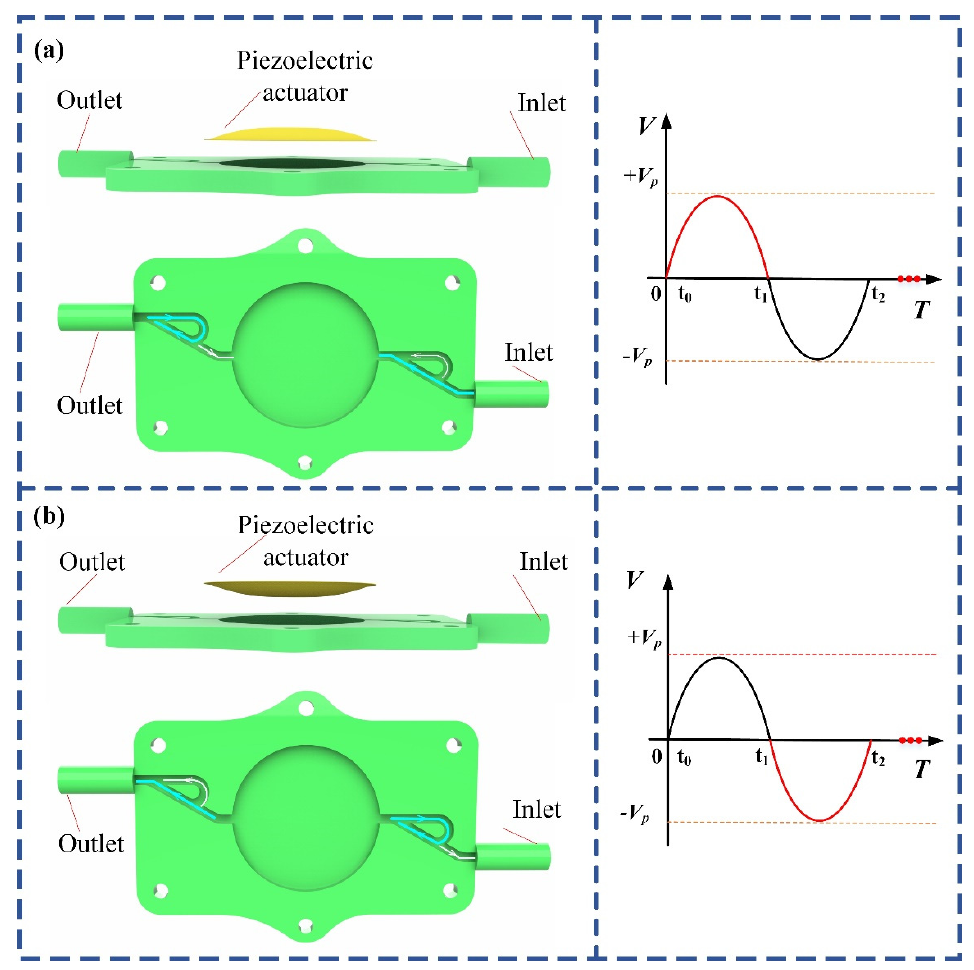
Figure 2. The valveless piezoelectric pump with the reverse diversion working principle: ( a ) liquid inflow; ( b ) liquid outflow.